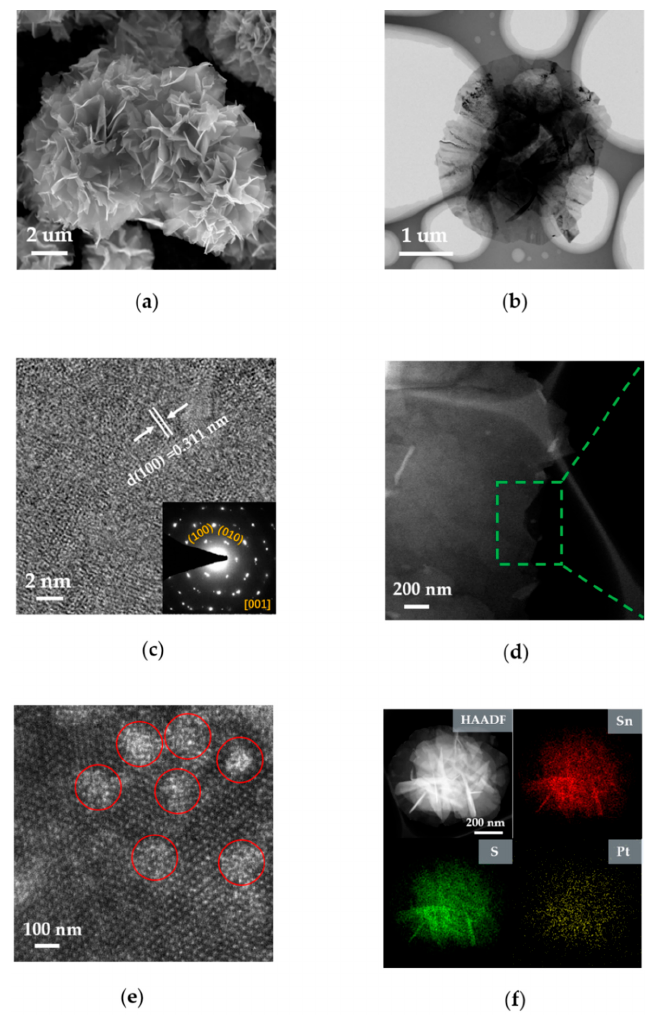
Figure 2. Structures of SnS 2 -Pt-3. ( a ) The SEM image of SnS 2 nanostructure. ( b ) The TEM image of low-magnification morphology of SnS 2 -Pt-3 nanosheets. ( c ) SnS 2 -Pt-3 of high-resolution transmission diagram, in which is the corresponding SAED pattern. ( d , e ) Atomic resolution HAADF-STEM image with some individual Pt clusters represented by red circles. ( f ) The HAADF image and EDS mapping of Sn, S and Pt element from a SnS 2 -Pt-3